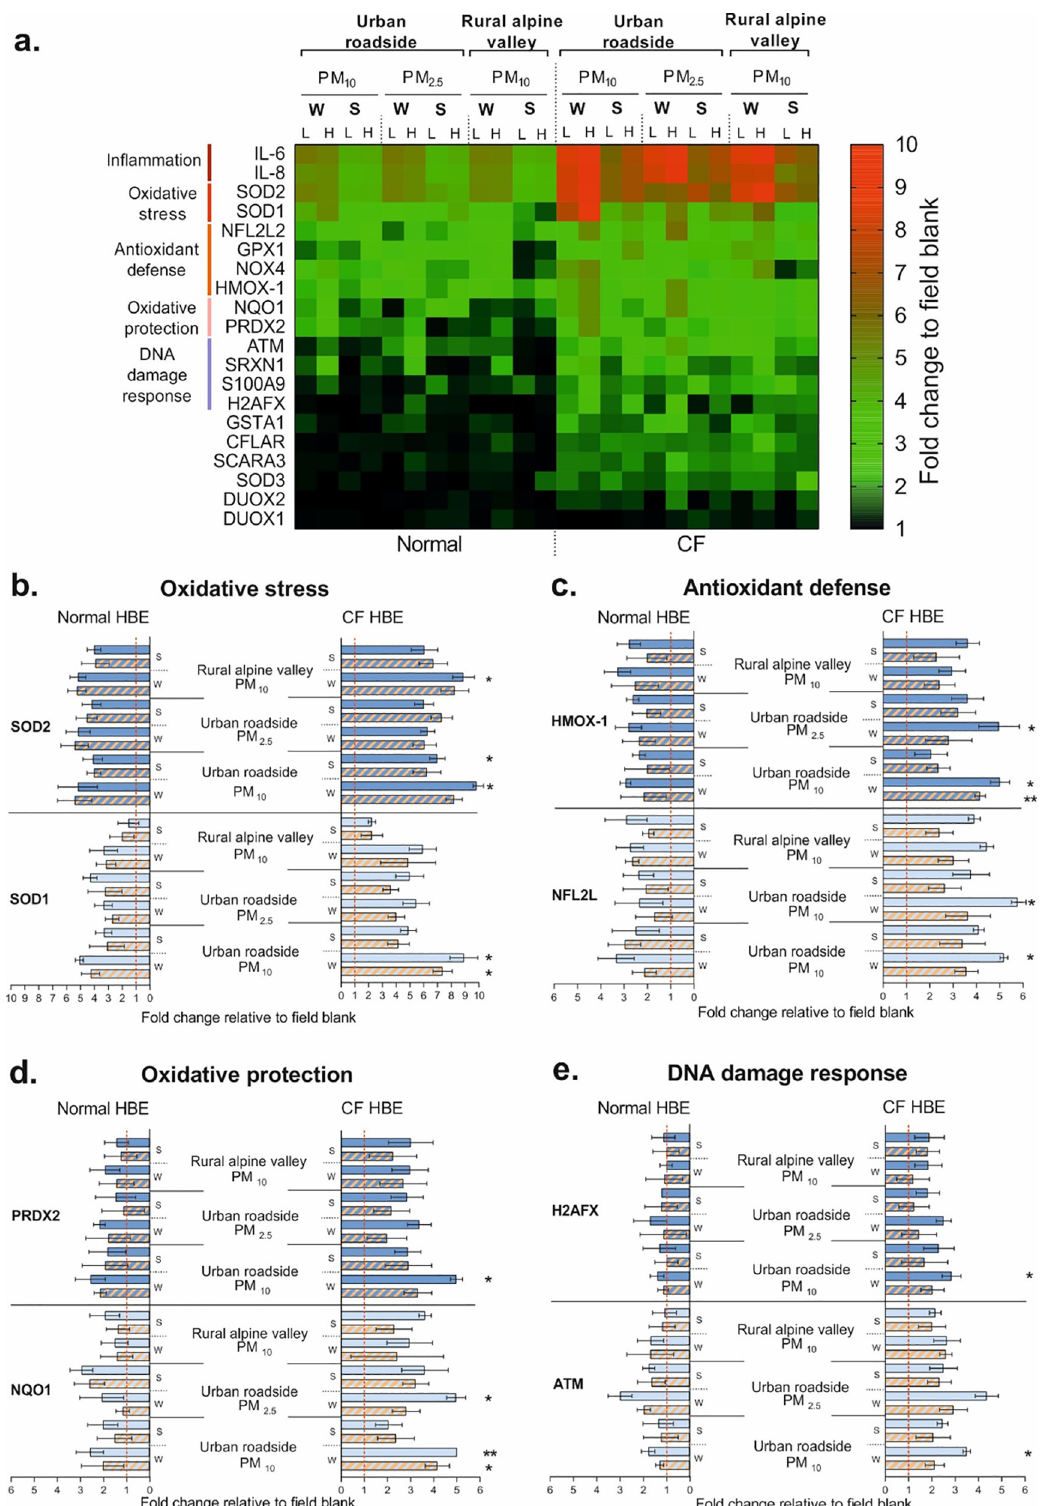
Fig 3. Screening of gene expression profiles and pathways associated with PM exposure in normal and CF HBE. ( a ) Gene expression profiles of the screened 20 genes, classified by PM category (PM 10 , PM 2.5 ) and site (urban roadside and rural alpine valley). Fold changes of gene expressions relative to field blank controls are reported ( n = 9). Abbreviations: IL = interleukin;